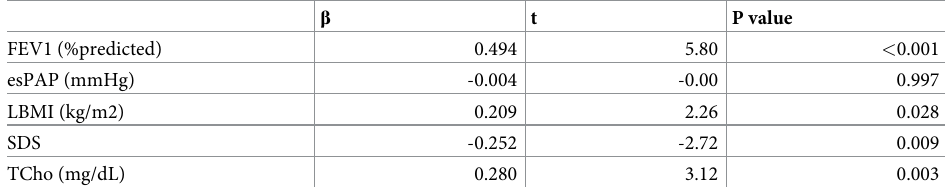
Table 4. Relationship between physical activity and clinical parameters assessed via multiple regression analysis.